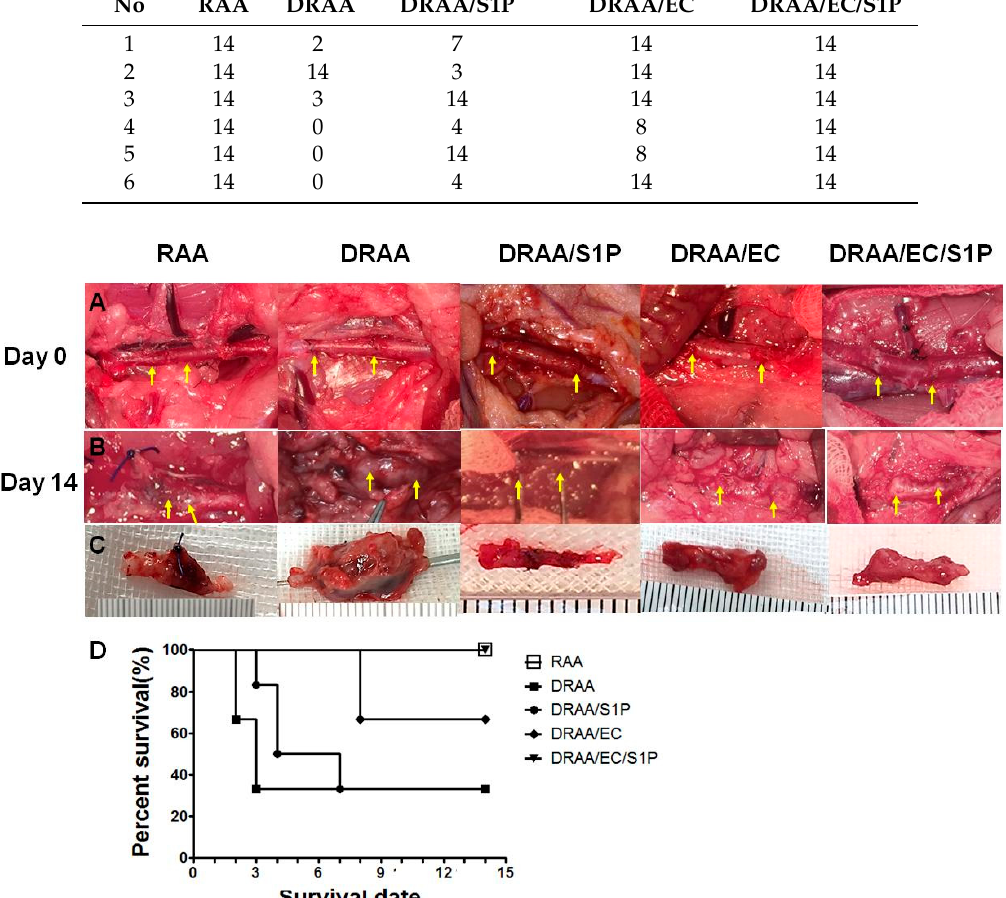
Figure 4. Graft implantation and survival data. (Panel A) Gross appearance of the grafts at Day 14 post-implantation (upper panel: rat abdominal aorta, arrows indicate suture lines; lower panel: explantation; left column: RAA, left-middle column: DRAA, middle column: DRAA/S1P, right-middle column: DRAA/EC, and right column: DRAA/EC/S1P). ( Panel B ) Gross appearance of the implanted graft at Day 14 post implantation; ( Panel C ) Gross appearance of the implanted graft at Day 14; ( Panel D ) The survival curve of the grafts.